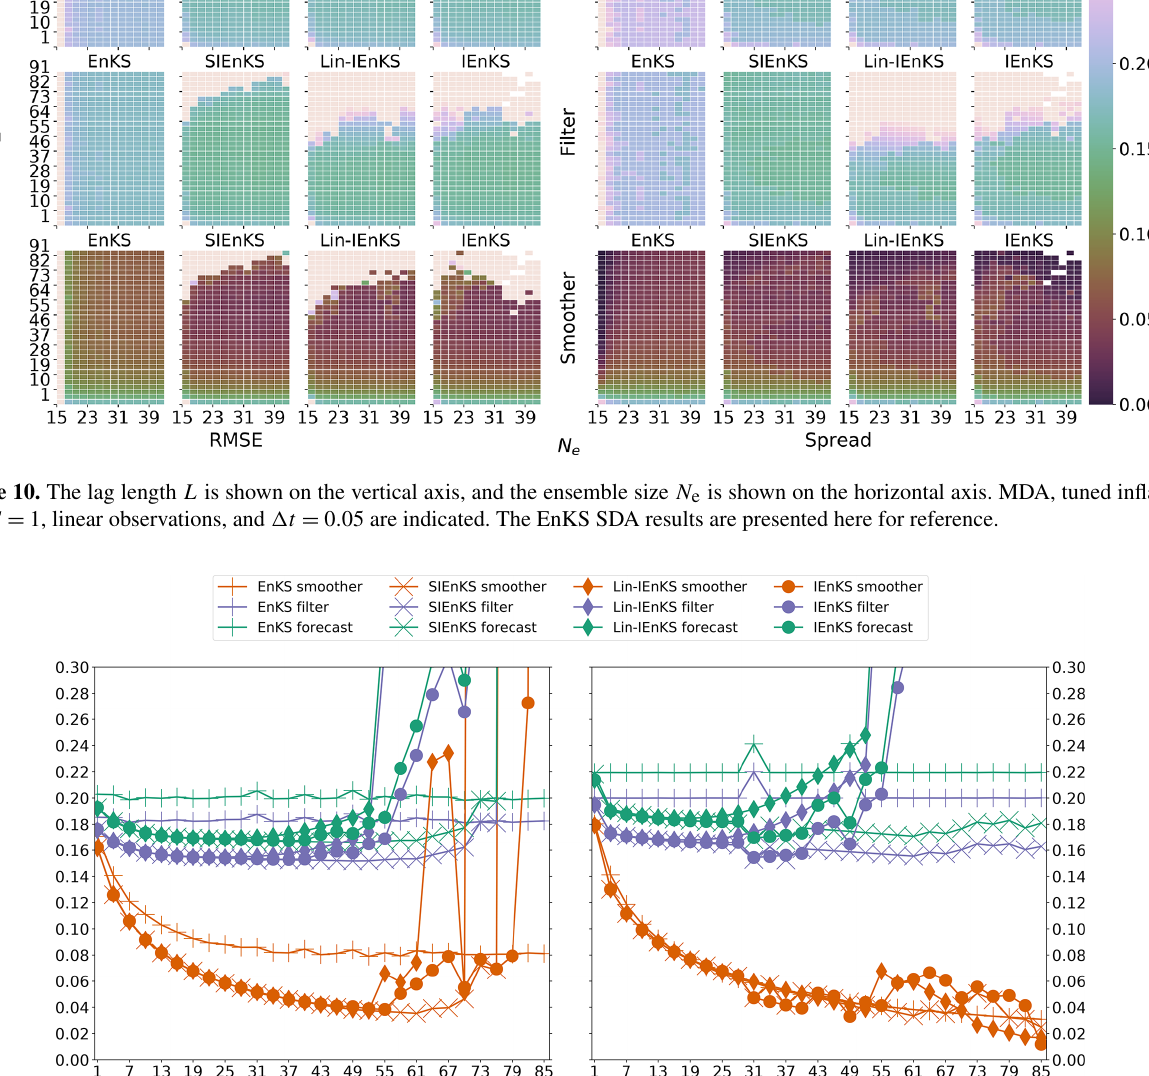
(iii) 4 L to 6 L ensemble simulations of the estimator’s